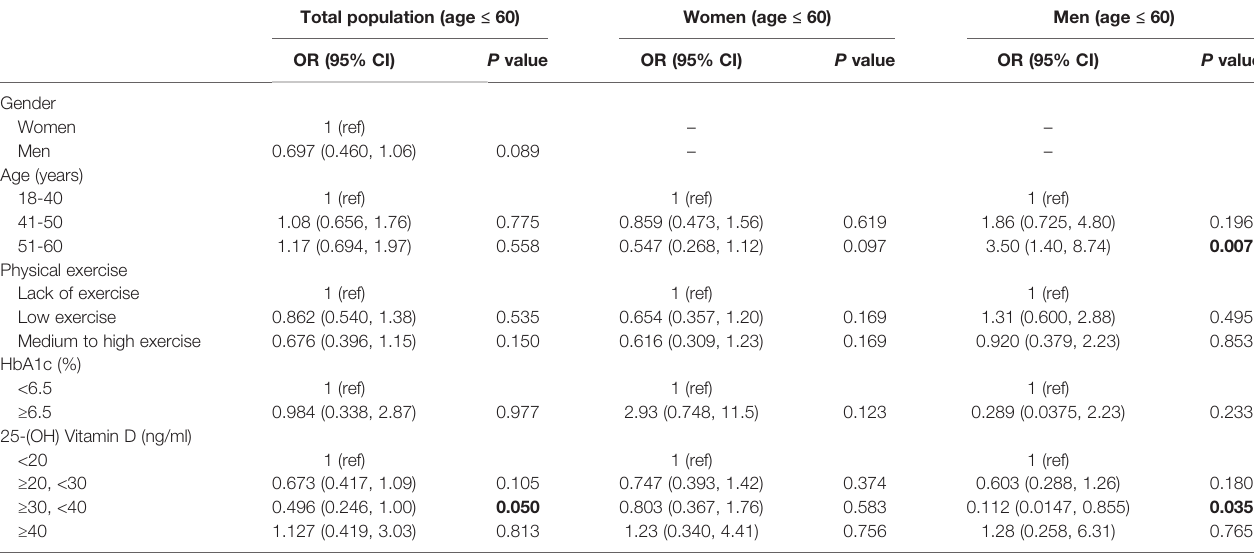
TABLE 4 | Factors associated with very low NKA < 100 pg/mL compared to normal NKA ≥ 500 pg/mL in subjects with age ≤ 60.